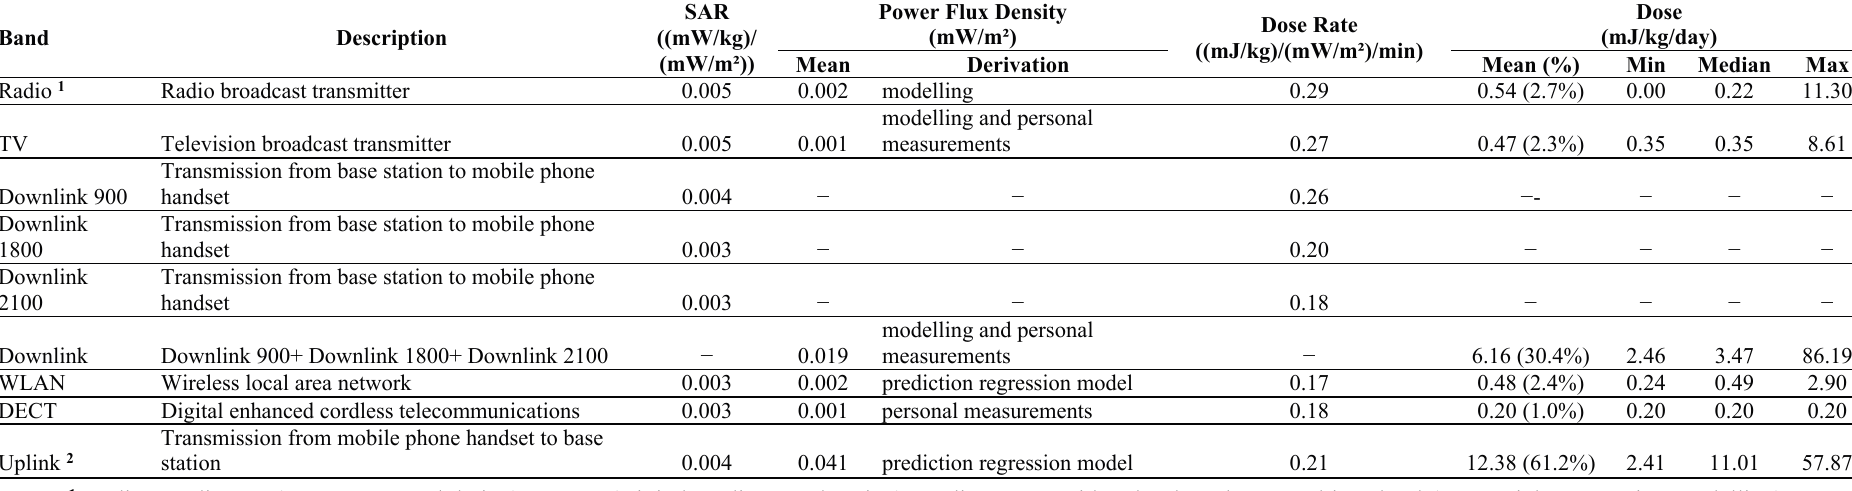
Table 5. Whole-body SAR, mean and derivation of the power flux density, whole-body dose rate (dose per 1min) and mean (with the corresponding percentage of the total whole-body far-field dose), minimum, median and maximum of the whole-body dose for the far-field